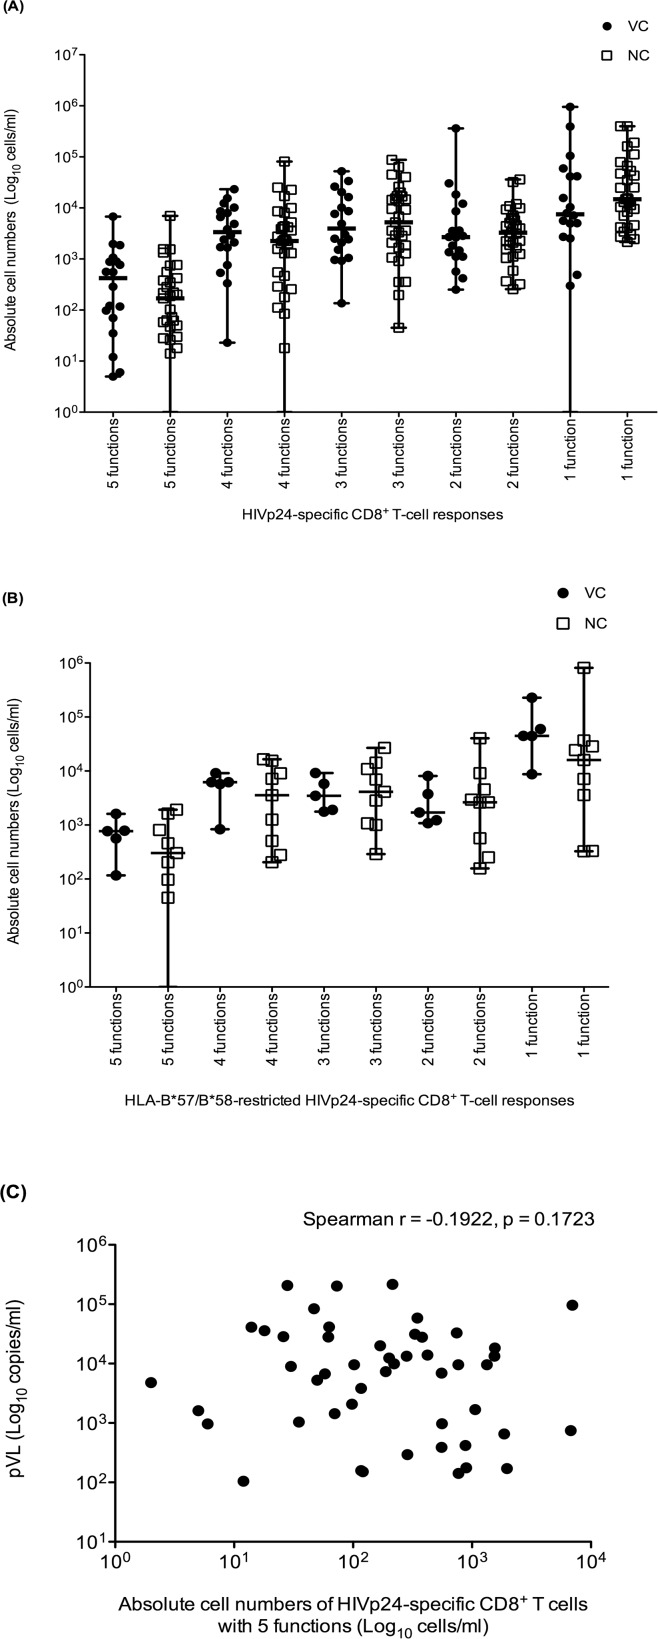
Measurement of functional quality of HIVp24-specific CD8+ T cells using polychromatic flow cytometry.
(A) Functional quality of CD8+ T-cell responses against HIVp24-specific OLPs (N = 23) in VC (N = 18, filled circle) and NC (N = 31, open rectangle) (B) Functional quality of CD8+ T-cell responses against HLA-B*57/B*58-restricted HIVp24-specific epitopes (N = 6) in HLA-B*57/B*58 positive VC (N = 5, filled circle) and NC (N = 9, open rectangle). The Y-axis represents absolute CD8+ T cells and the X-axis represents CD8+ T cells with 5-, 4-, 3-, 2-, and 1-function in VC and NC. (C) The correlation between the absolute cell numbers of 5-functional HIVp24-specific CD8+ T cells and pVL was analysed using Spearman’s rank test.